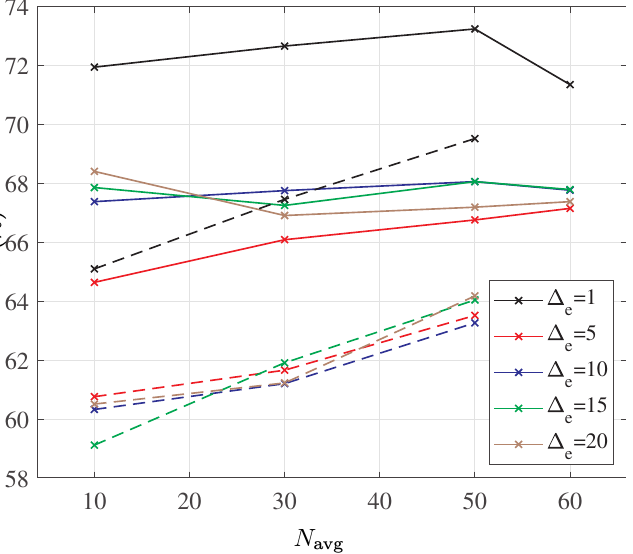
Figure 7. The accuracy of the random forest classifier vs. the number of averaged fragments under different misalignment bounds ∆ e . Solid line: consecutive segment selection; dashed-line: random segment selection.